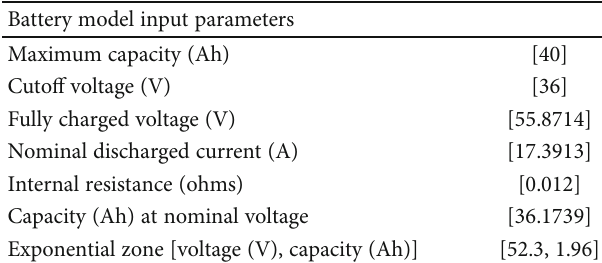
Table 2: Battery model